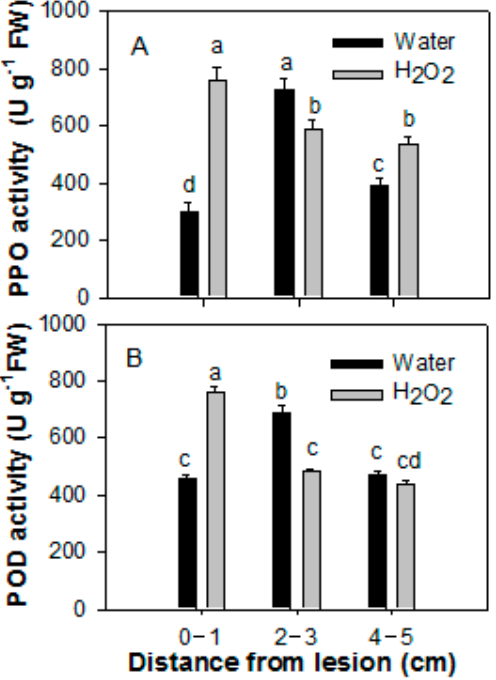
Figure 5. Effect of 20 mM H 2 O 2 treatment on the activities of PPO ( A ) and POD ( B ) of papaya fruit inoculated with Colletotrichum gloeosporioides . Papaya fruit were inoculated with Colletotrichum gloe ‐ osporioides immediately after H 2 O 2 treatment. The pericarp tissue of papaya fruit inoculated with C. gloeosporioides were sampled after 8 days of incubation at 25 °C at 0–1, 2–3, and 4–5 cm from the lesions, respectively. POD, peroxidase; PPO, polyphenol oxidase. The data were expressed as the means ± SE of three biological replicates. Different letters indicate significant differences.